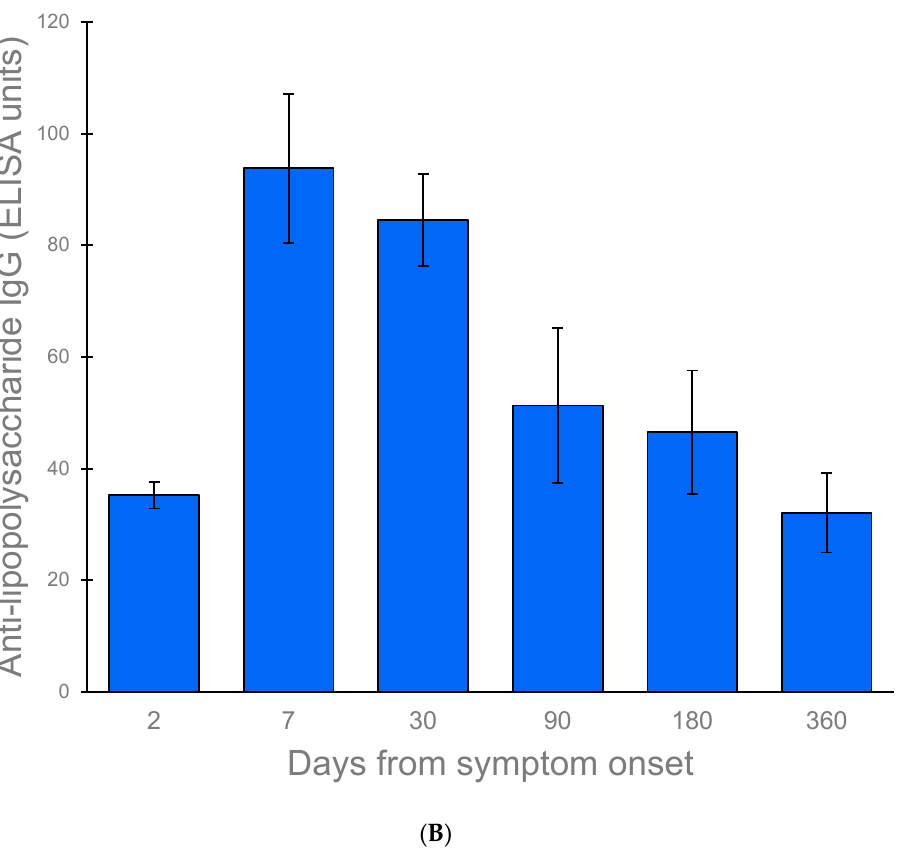
Figure 5. ( A ) Forest plots of the kinetics of anti-lipopolysaccharide IgG following cholera [37–40,42]. ( B ) Kinetics of anti-lipopolysaccharide IgG following cholera. Table 5. Kinetics of anti-lipopolysaccharide IgG following cholera.